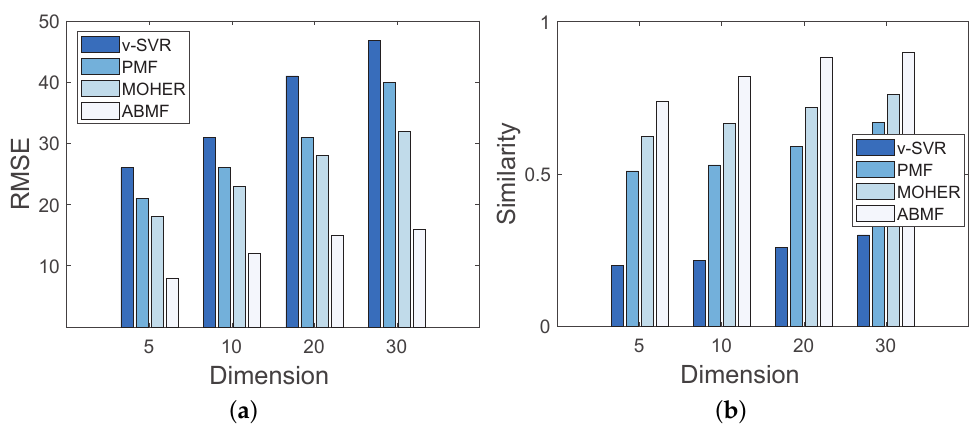
Figure 11. Performance with different dimensions on Foursquare (NYC) dataset: ( a ) Performance on RMSE; ( b ) Performance on Similarity.